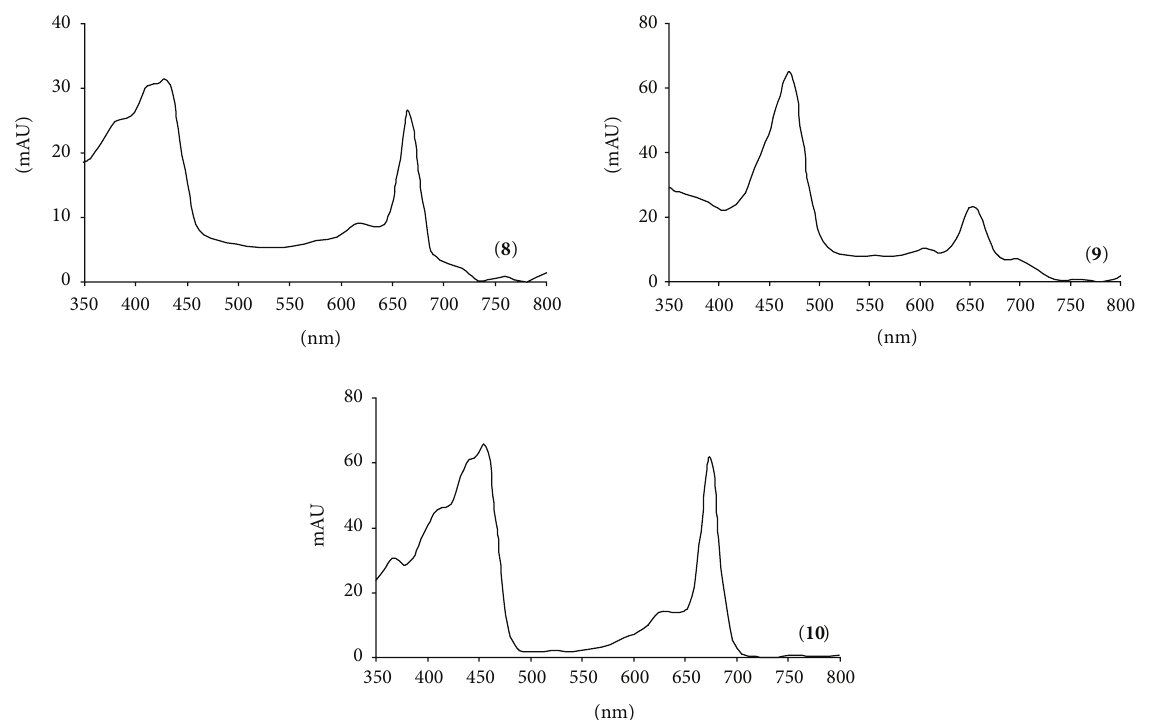
Figure 6: UV-vis spectra of chlorophyll b ( 8 ), bacteriochlorophylls b ( 9 ), and chlorophyll a ( 10